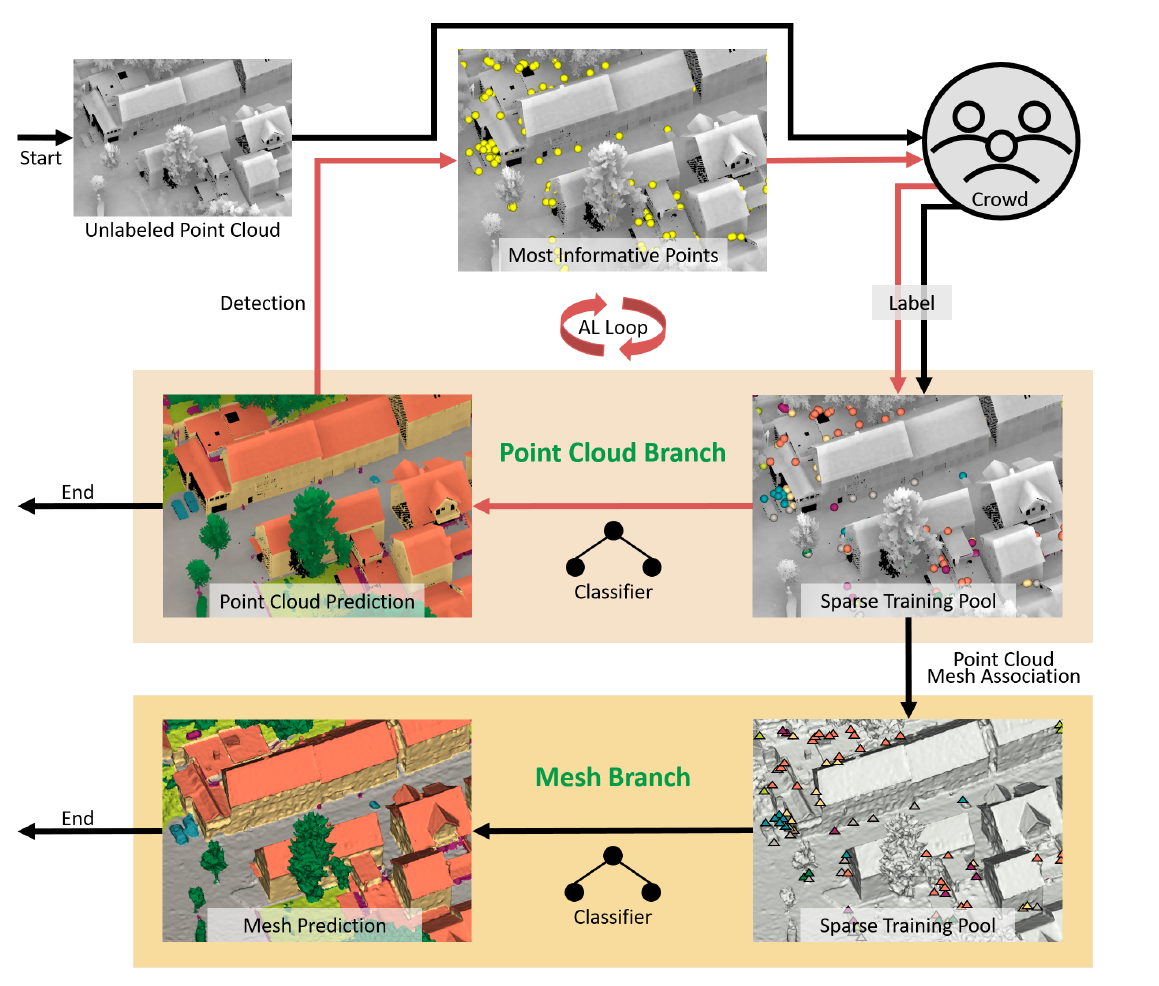
Figure 1. Crowd-based Active Learning pipeline for coupled semantic segmentation of both the point cloud and the mesh.